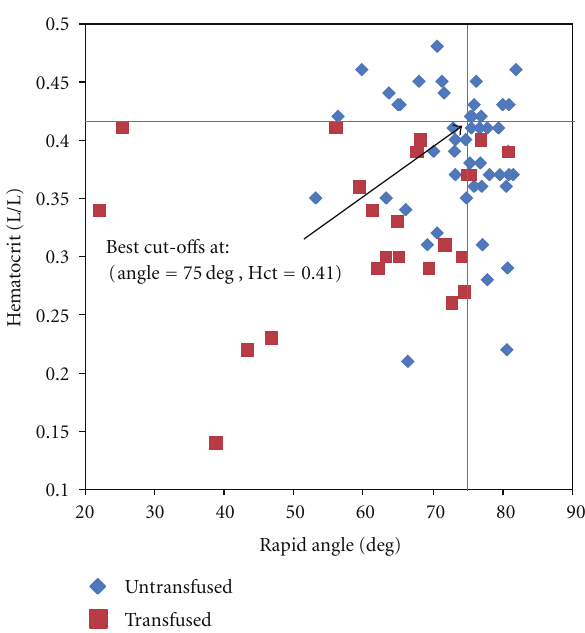
Figure 3: Rapid α -Angle plotted against haematocrit with calcu- lated cuto ff